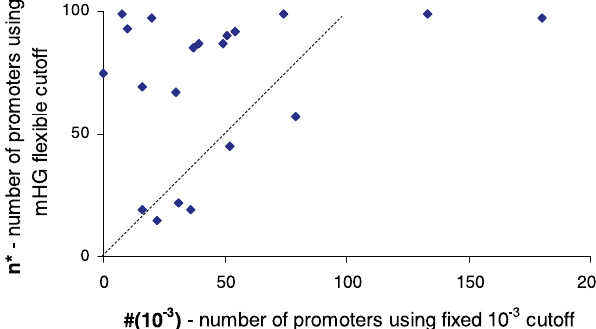
Figure 6. Comparison of the Target Sets Sizes as Determined by the Fixed versus the mHG Flexible Cutoffs Each dot represents a ChIP–chip experiment where the x and y coordinates are the number of promoters with p , 10 (cid:2) (standard cutoff) and the number of promoters as determined by the mHG cutoff, respectively. The dotted line is x ¼ y . TF names are given in Table